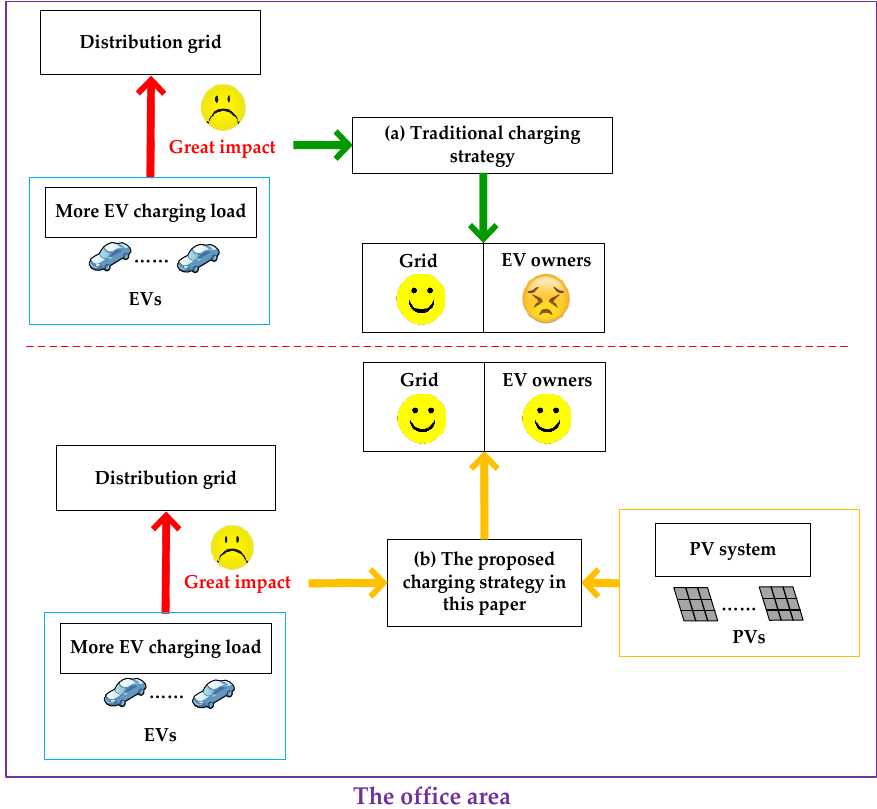
Figure 2. Comparison of two kinds of strategies: ( a ) traditional charging strategy & ( b ) proposed charging strategy in this paper.